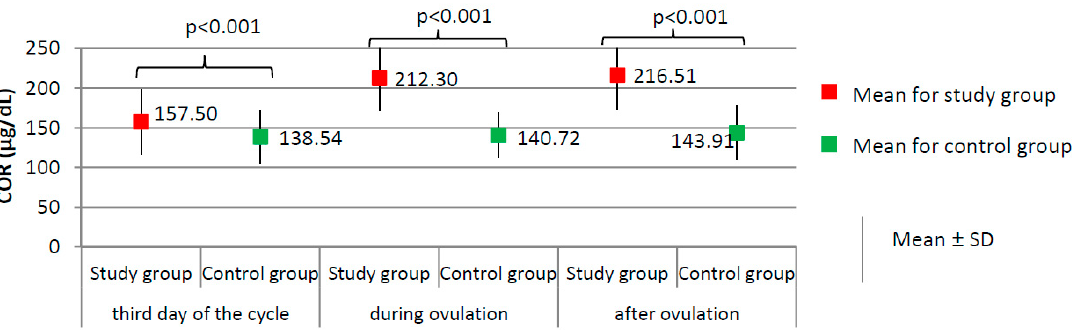
Figure 1. Comparison of LH (luteinizing hormone) ( a ), E2 (estradiol) ( b ), and P (progesterone) ( c ) Int. J. Environ. Res. Public Health 2020 , 17 , x between the study group ( N = 205) and the control group ( N = 100). between the study group ( N = 205) and the control group ( N = 100).